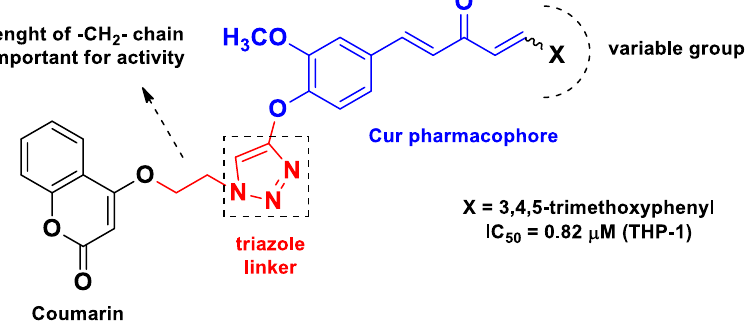
Figure 4. Coumarin –Cur hybrids developed by Bedi’s research group [58].